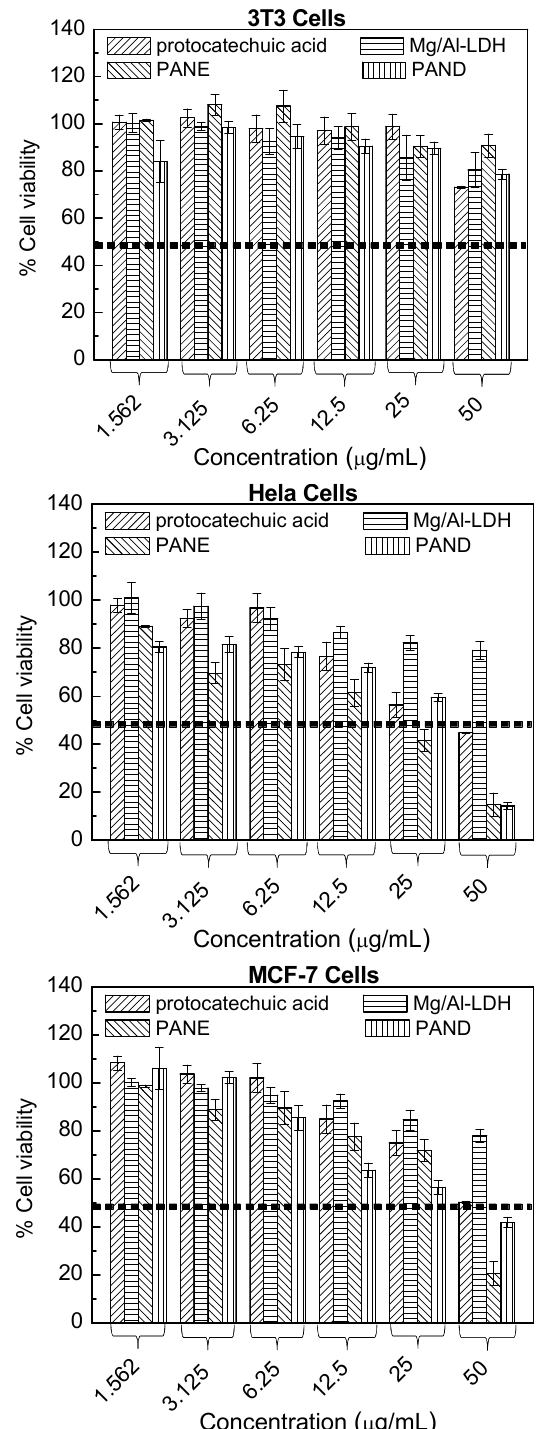
Figure 5. Cell viability (MTT assay) of 3T3, HeLa, and MCF-7 cell lines exposed to various concentrations of protocatechuic acid, PANE, PAND and Mg/Al-LDH (with permission from Dove Press, Auckland, New